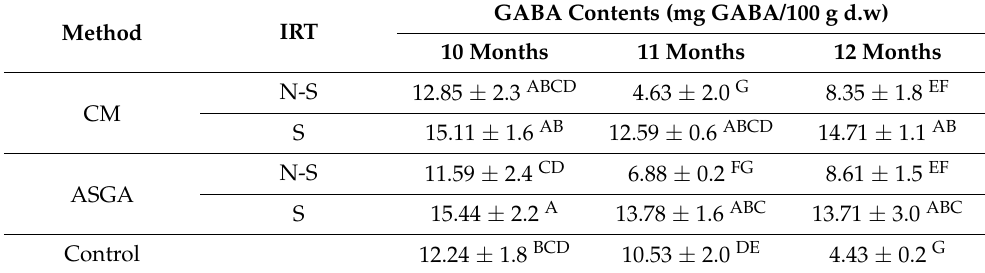
Table 4. Comparison of GABA contents of germinated rough rice samples soaked using the conven- tional method (CM) and an automatic soaking and germination accelerator unit (ASGA) with and without stimulation via infrared radiation treatment (IRT) and ungerminated rice (control) in each storage period.